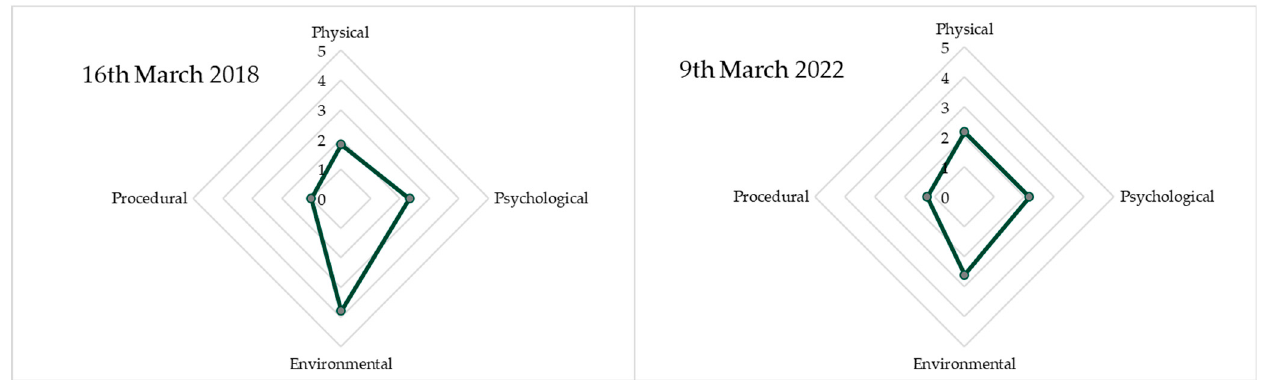
Figure 6. Visual depiction of welfare scores for one individual on two separate days. Reduction in the area of the polygon (from CWAS 9.39 on 16 March 2018 to 8.16 on 9 March 2022) indicates the potential improvement to welfare resulting primarily from a change in habitat.